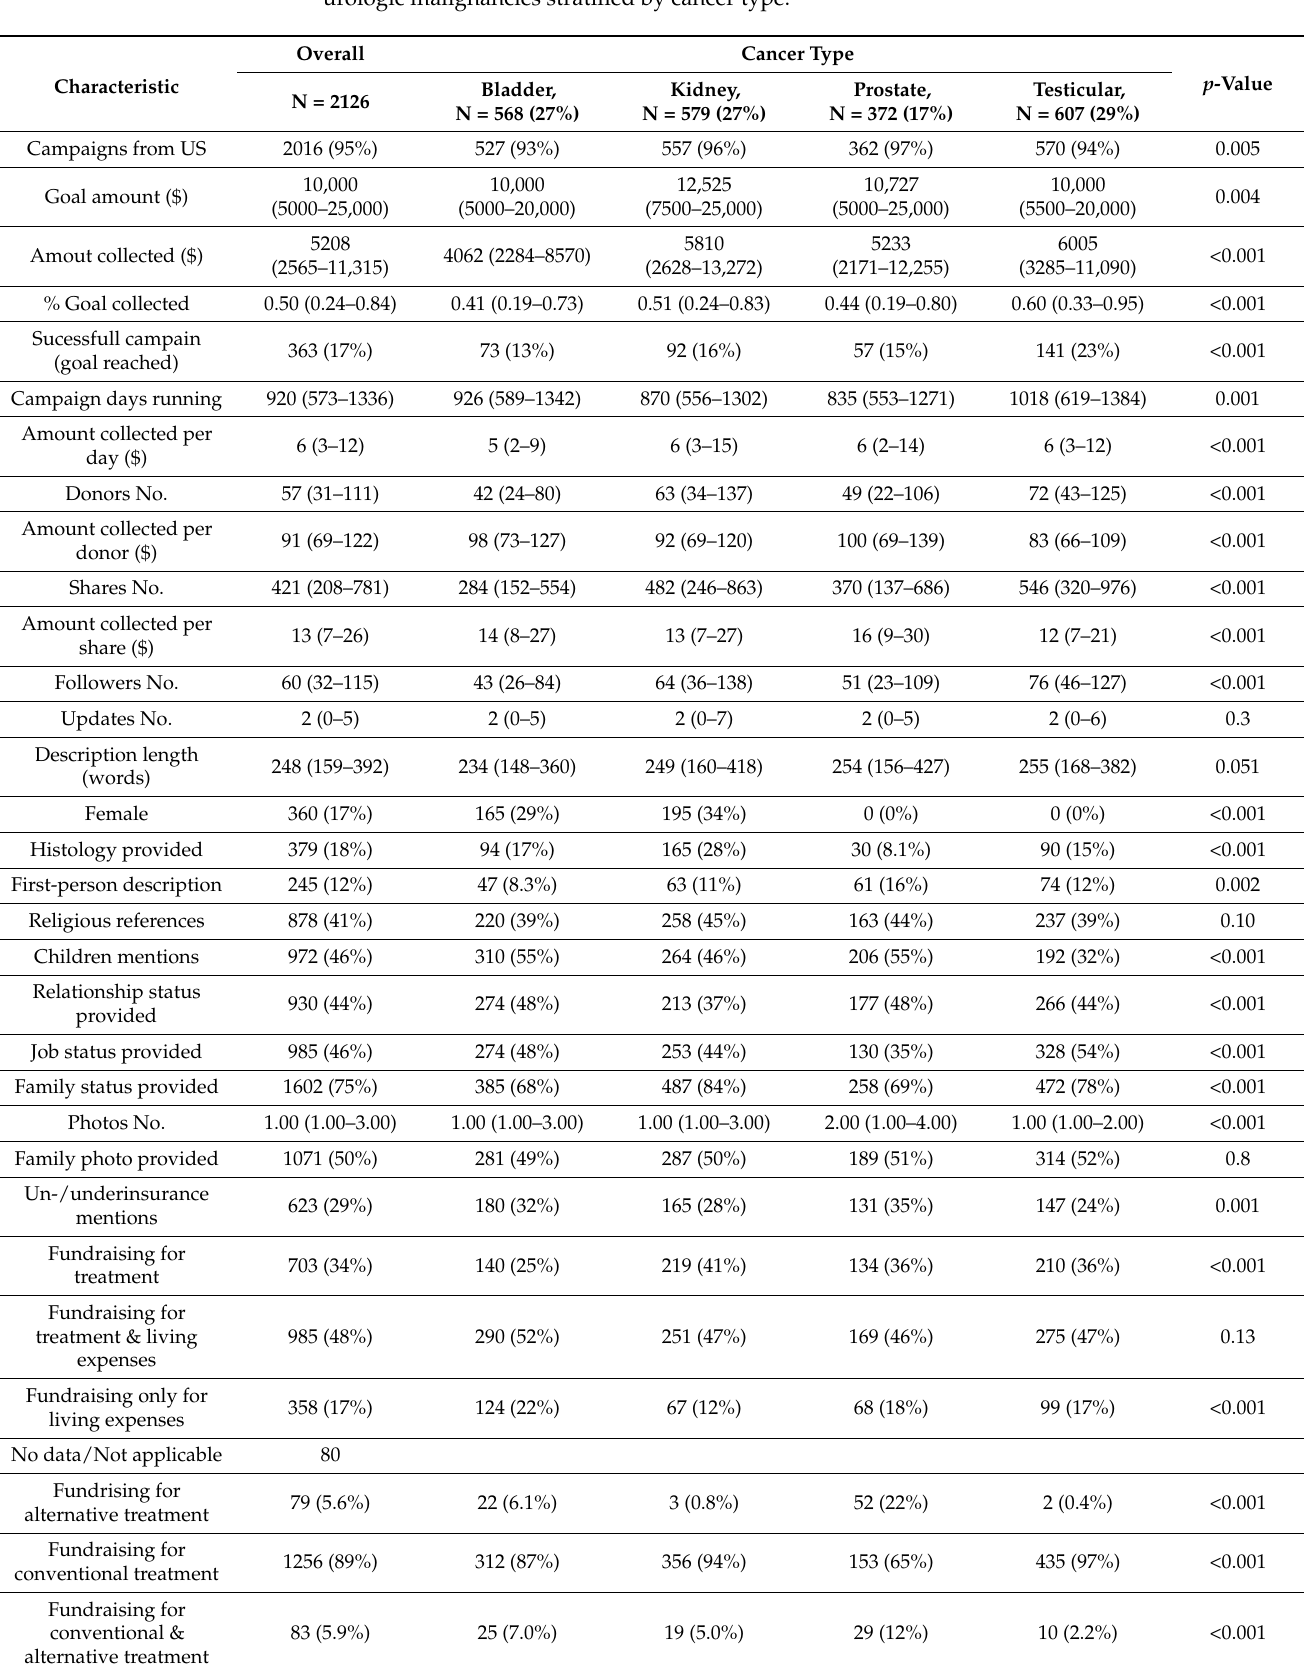
Table 1. Characteristics of 2126 GoFundMe.com online crowdfunding campaigns fundraising for urologic malignancies stratified by cancer